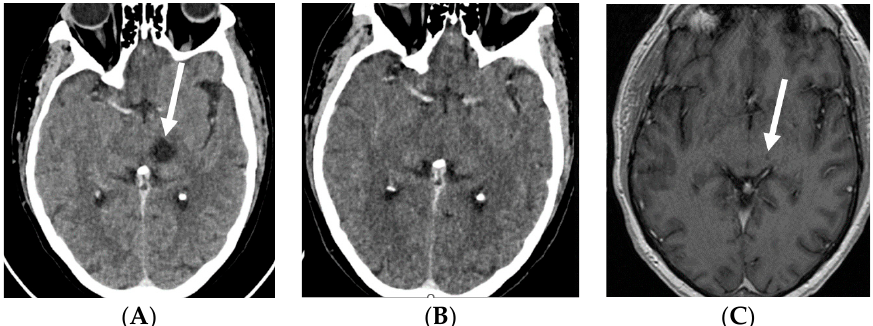
Figure 1. Contrast-enhanced CT scans: baseline, prior to EV treatment ( A ), and after three cycles of EV ( B ), and contrast-enhanced T1-weighted MRI after three cycles of EV ( C ). Baseline CT shows a ring-enhancing cystic/necrotic tumor in the left thalamus, whereas follow-up CT fails to show minute residual tumor. However, this is still slightly visible on the MRI scan (arrows). Abbreviations: CT, computed tomography; EV, enfortumab vedotin; MRI, magnetic resonance imaging.